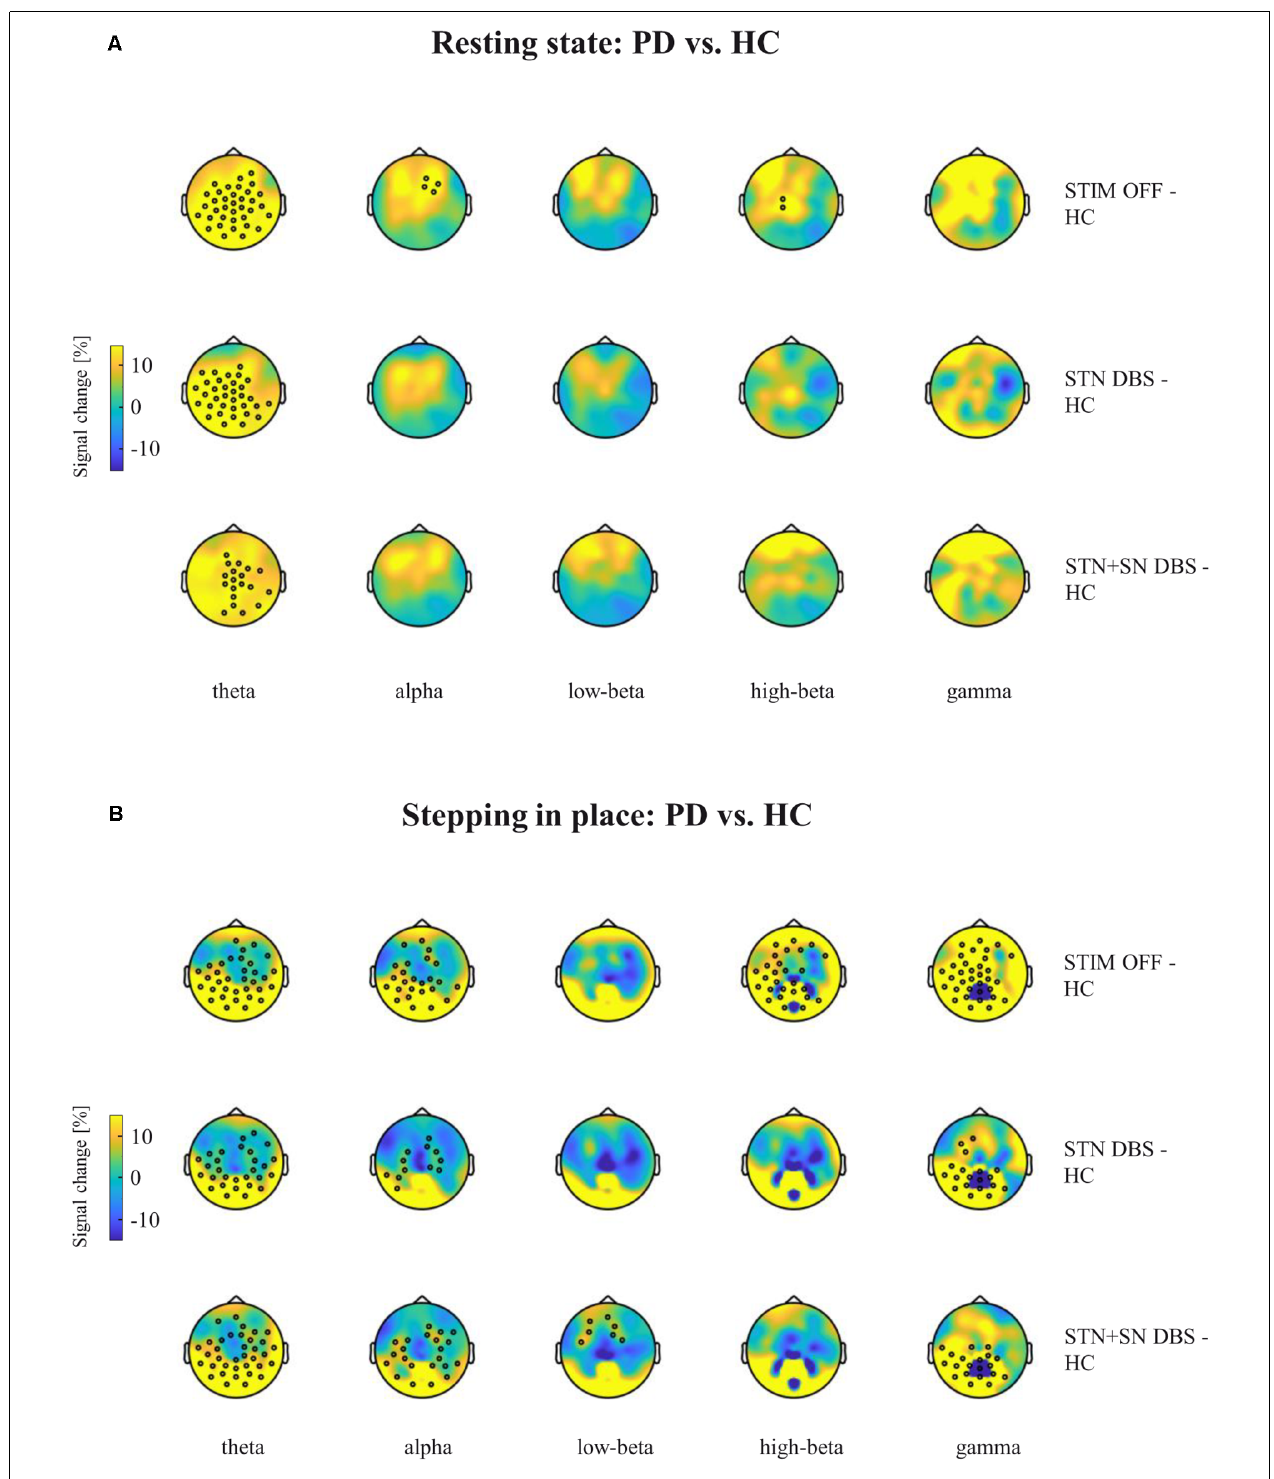
FIGURE 4 | Cortical activity differences between PD patients and healthy controls (HCs) during resting-state and stepping in place. Topographic percentual power signal change between HCs and PD patients in the three DBS settings (rows) is displayed for (A) the resting-state condition and for (B) the stepping in place condition separately for the five frequency bands (columns). Black circles represent significant clusters of EEG sensors showing significant signal changes between motor conditions based on cluster-based permutation tests. In panel (A) the high-beta power cluster of midline-central channels was increased with p -value closed to the alpha level ( p =